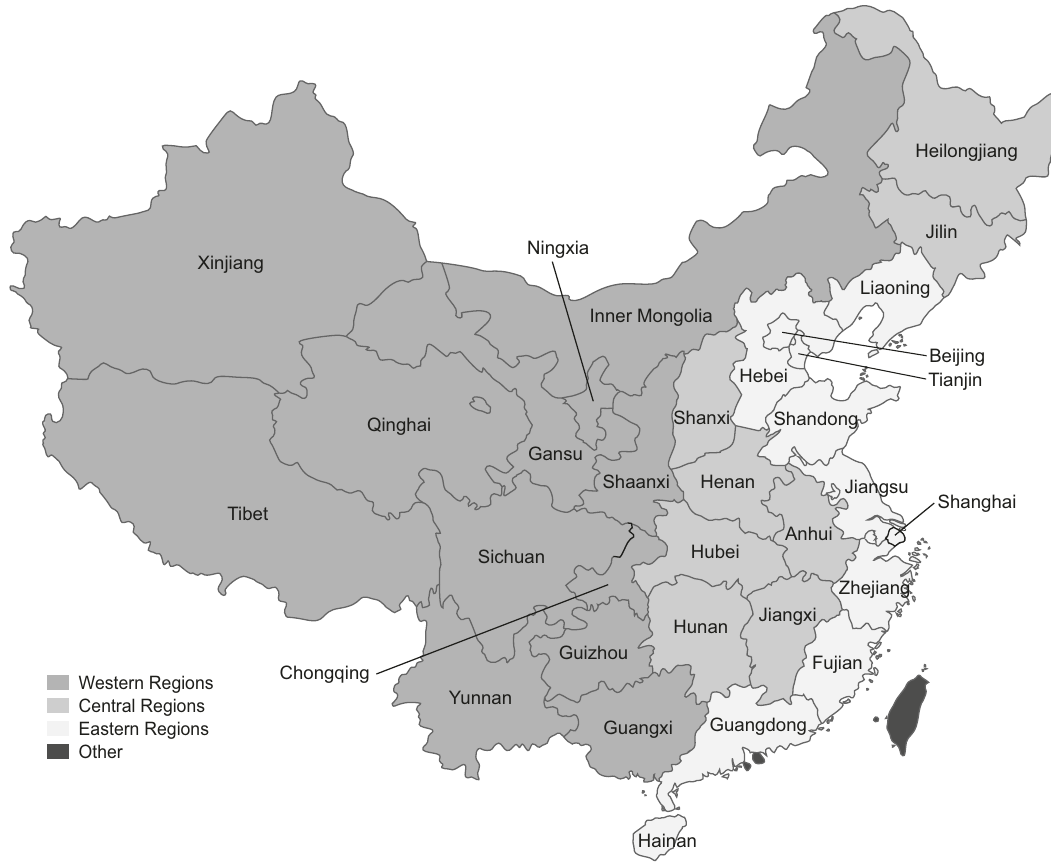
Fig. 1 Western regions, central regions and eastern regions of China. The regions in China were geographically and economically divided into three areas: western regions, central regions, and eastern